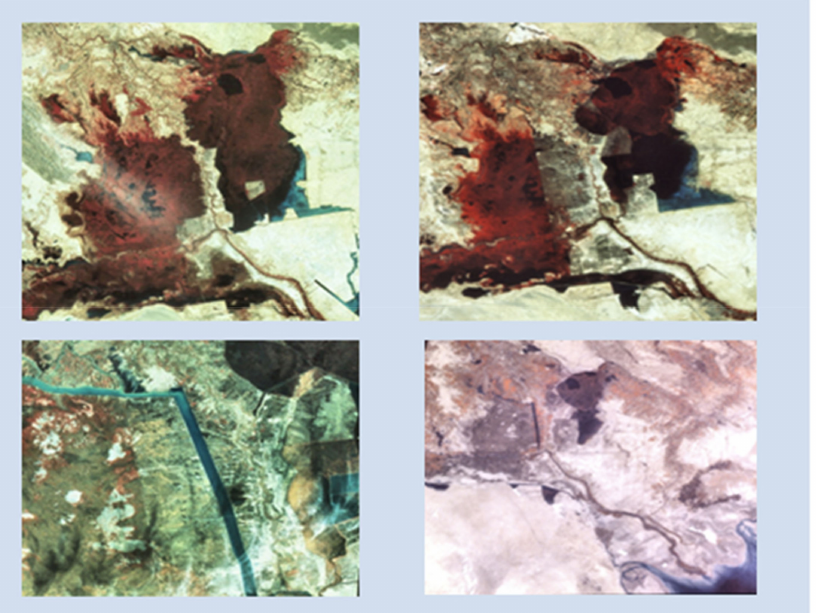
Figure 23. Landsat imagery of the Mesopotamian marshes showing the progressive desiccation from the 1970s to 2000